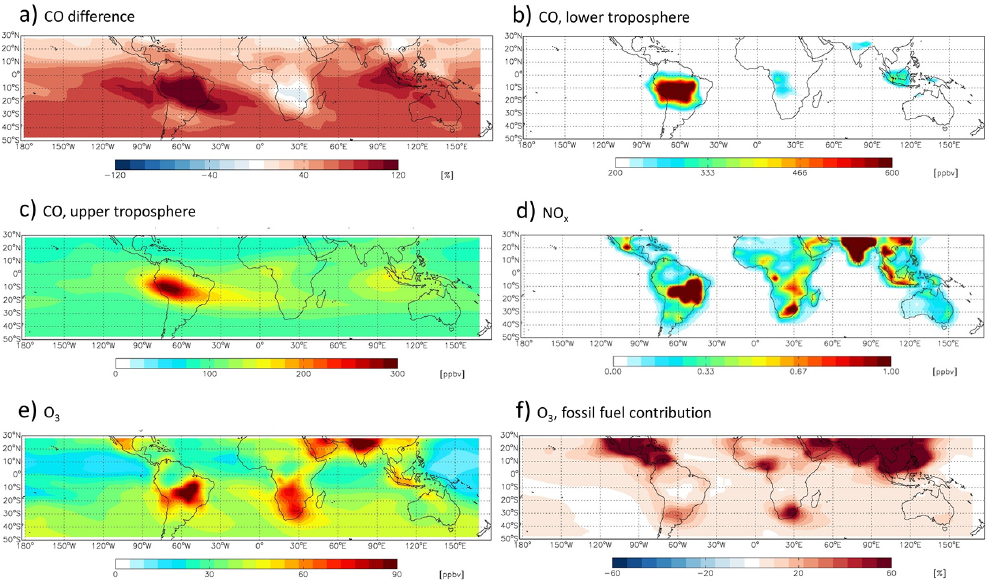
Figure 8. Percentage difference (2050s–2000s) of CO distribution in lower troposphere (a) , CO concentrations (ppb) in lower (b) and up- per (c) troposphere, lower tropospheric NO x (d) and O 3 (e) distribution (ppb), and fossil fuel contribution to total O 3 (f) in future September.